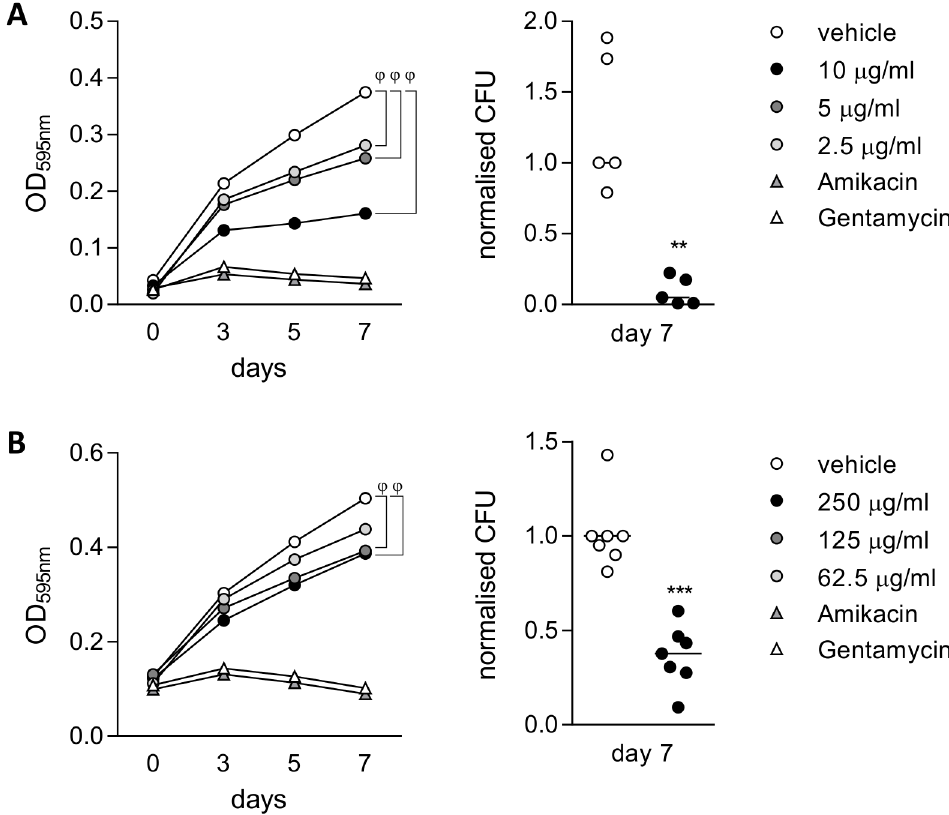
Fig 8. PBECs expressantimycobacterial effectors DEFB4 and S100A7 .Mtb H37Rv was grown in the presence of the indicated concentrations of recombinant (A) hBD2, (B) psoriasin or vehicle control (veh). Amikacin and gentamycinwere used as positive controls at 200 μ g/ml and 100 μ g/ml respectively.Mtb growth was measuredby opticaldensity at 595nm (OD 595nm ) over time. Mean readingsof one representative experiment are shown. At day 7, cultures were plated to measure the bacterialburdenby CFU (n = 3 representative for two independentH37Rv cultures). Groups were comparedagainstvehicle control at day 7 by one-wayANOVA or Mann-Whitney test (poolednormalisedCFU data from three (psoriasin) or two (hBD2) independent experiments are shown). Medianis shown. ϕ , p < 0.001; ** , p < 0.01; *** , p < 0.001.